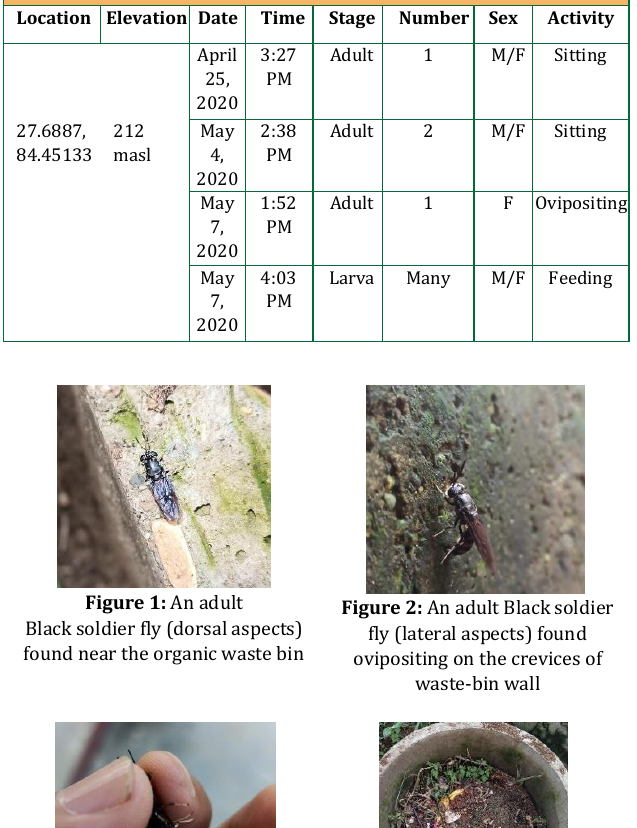
Figure 12: Antenna of the captured fly with spatulated apical flagellum